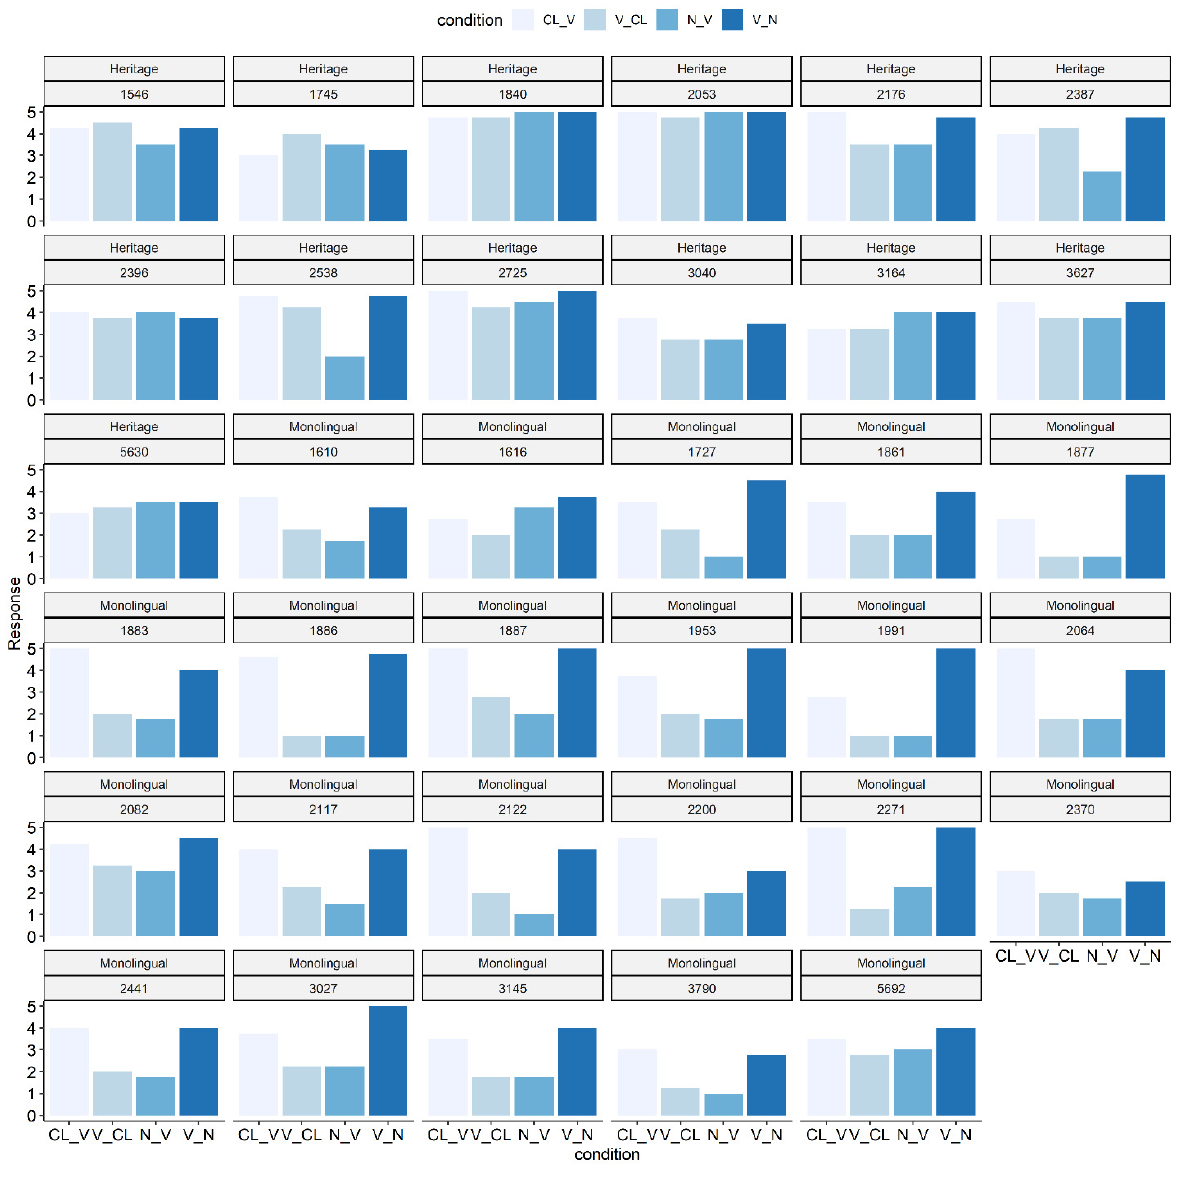
Figure 4. Individual results in AJT in heritage and baseline (MONO) groups.